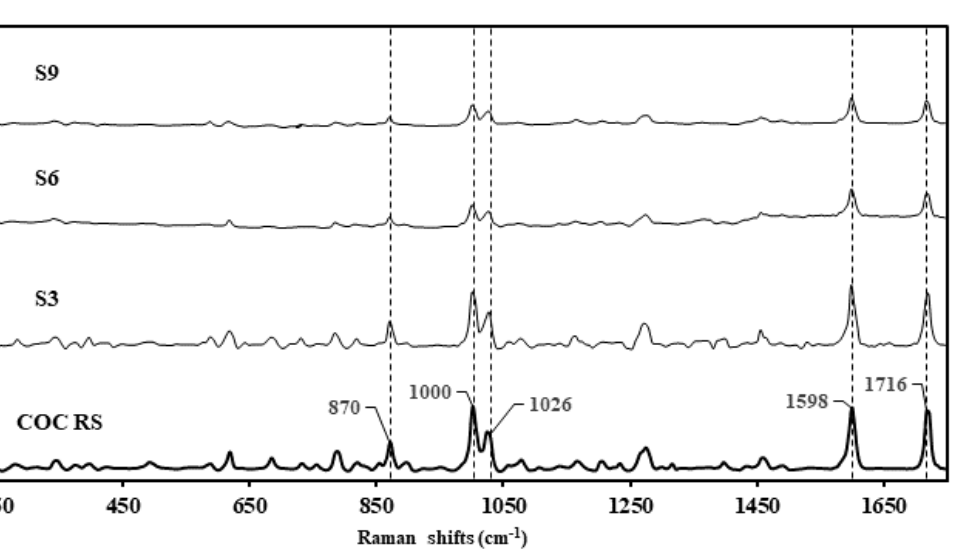
Figure 2. Images of each sample surrendered for analysis at the drug-checking clinic; each sample was weighed and described prior to test (Table 1). Please note sample S1, a herbal material, was suspended in methanol prior to the image being taken.